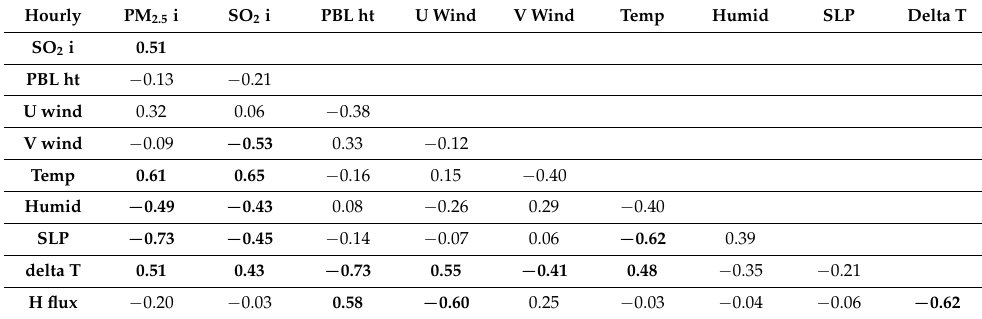
Table 7. Simultaneous pair-wise cross-correlation of surface air constituents and ERA5 1000–850 hPa meteorology variables over the Durban-area: hourly case study (10–24 July 2015 N = 360). Hourly PM 2.5 i SO 2 i PBL